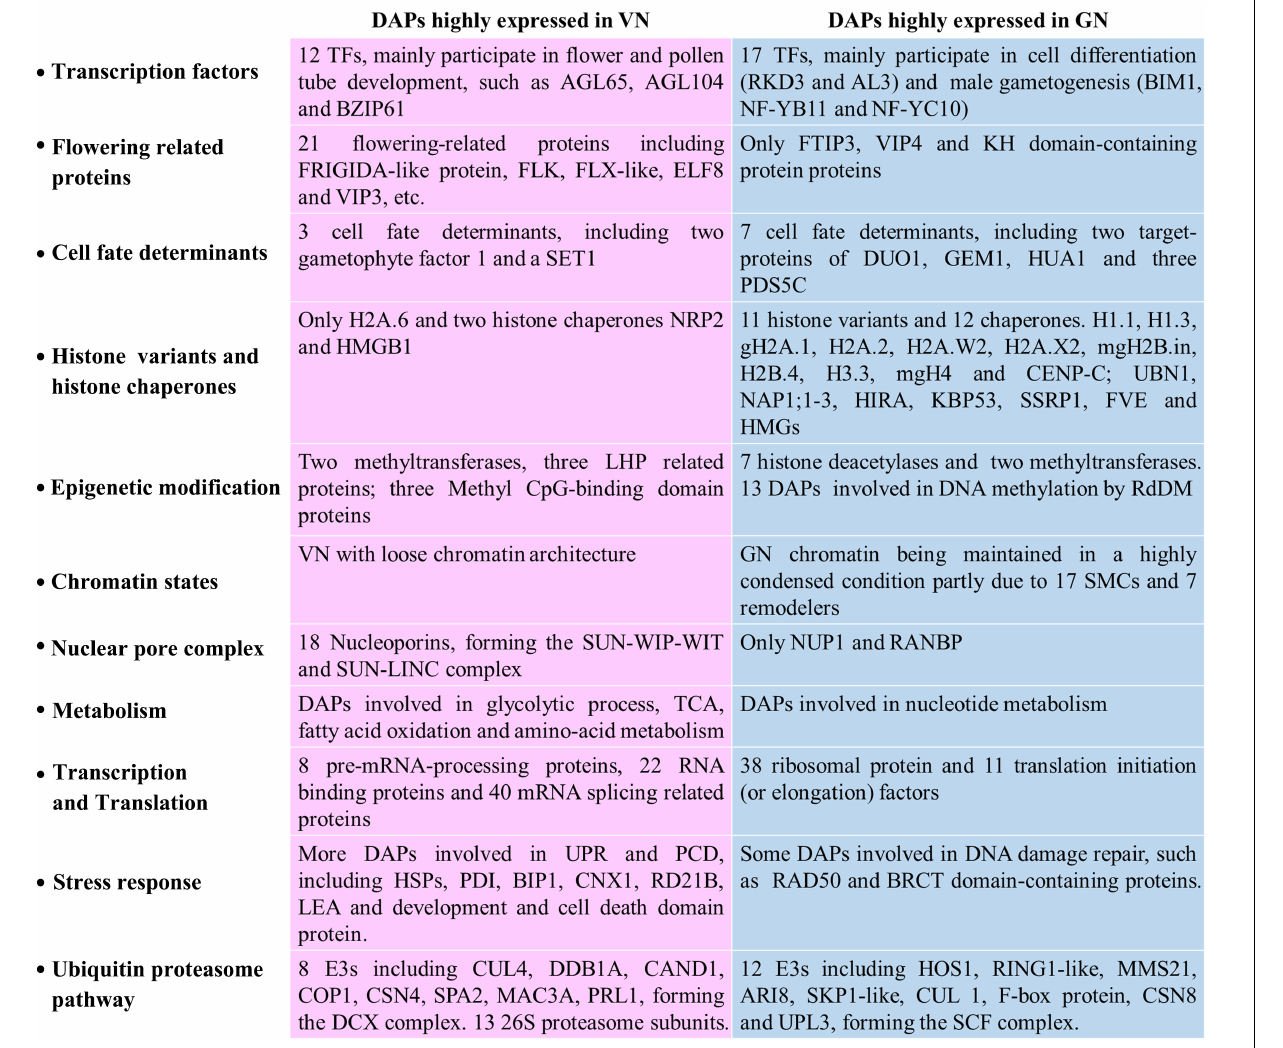
FIGURE 7 | Summary of the prominent protein composition difference between VN and GN after fate